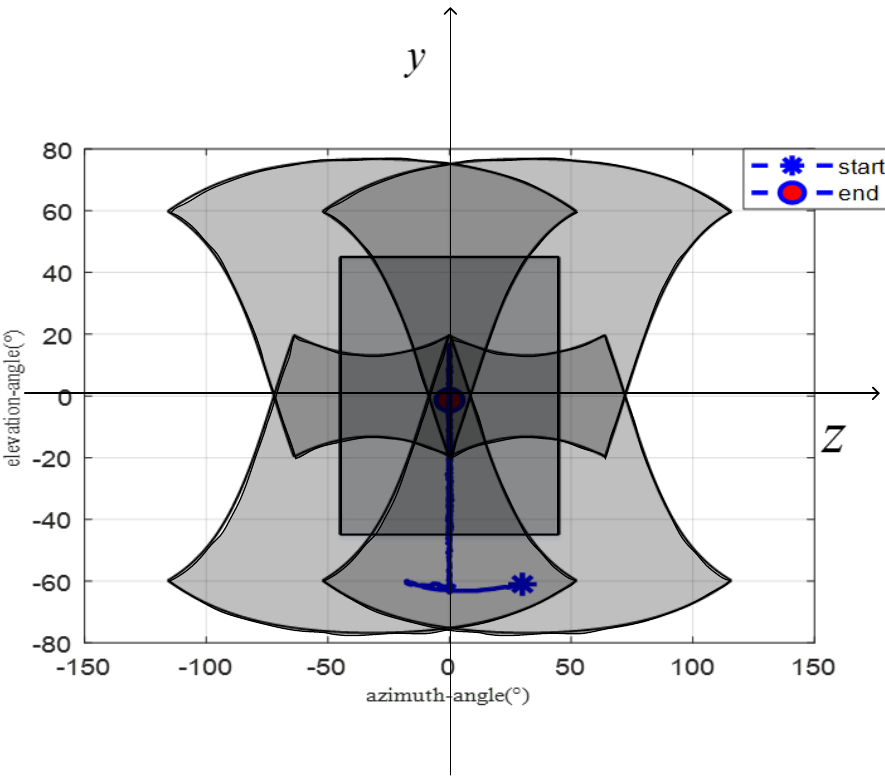
Figure 15. The variation range of the field angle.